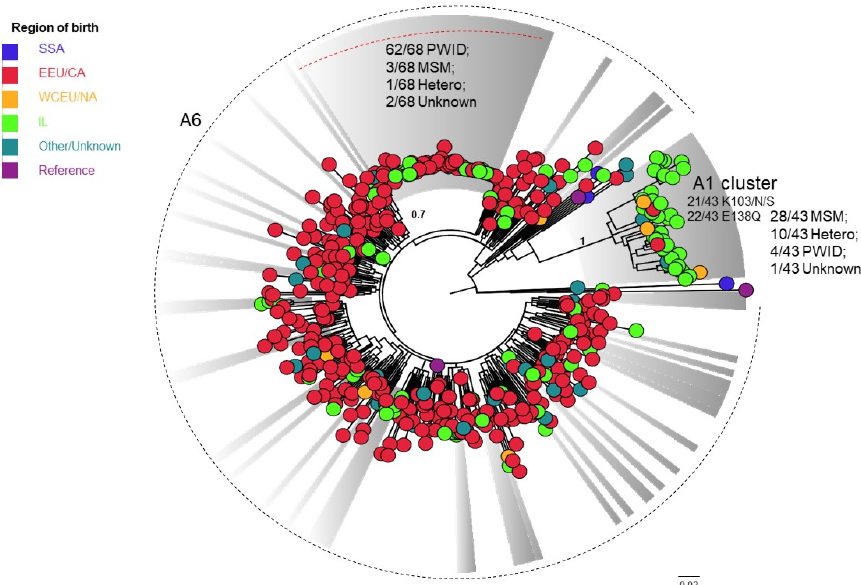
Figure 4. Phylogenetic analysis of subtype A sequences, N = 482. A phylogenetic tree of the pol region of subtype A sequences from 482 HIV-1 patients using the maximum likelihood (ML) with GTR + G + I model is shown. Included are three reference sequences (Table S1). The tree was visualized in Fig Tree version 1.4.4. Clusters (bootstrap values > 0.7) are colored in grey. Countries of origin are colored as follows: SSA (Sub-Saharan Africa) in navy blue; EEU/CA (Eastern Europe and Central Asia) in red; WCEU/NA (Western and Central Europe and North America) in orange; IL (Israel) in light green; other/unknown birthplace in turquoise; reference sequences in purple. The dashed line presents sub-subtype A6. PWID—people who use injection drug; MSM—men who have sex with